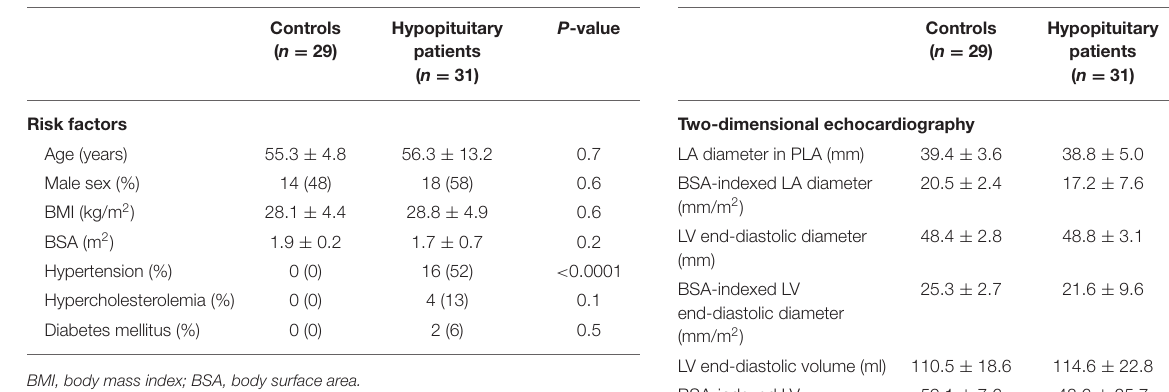
TABLE 2 | Two-dimensional echocardiographic data of hypopituitary patients and